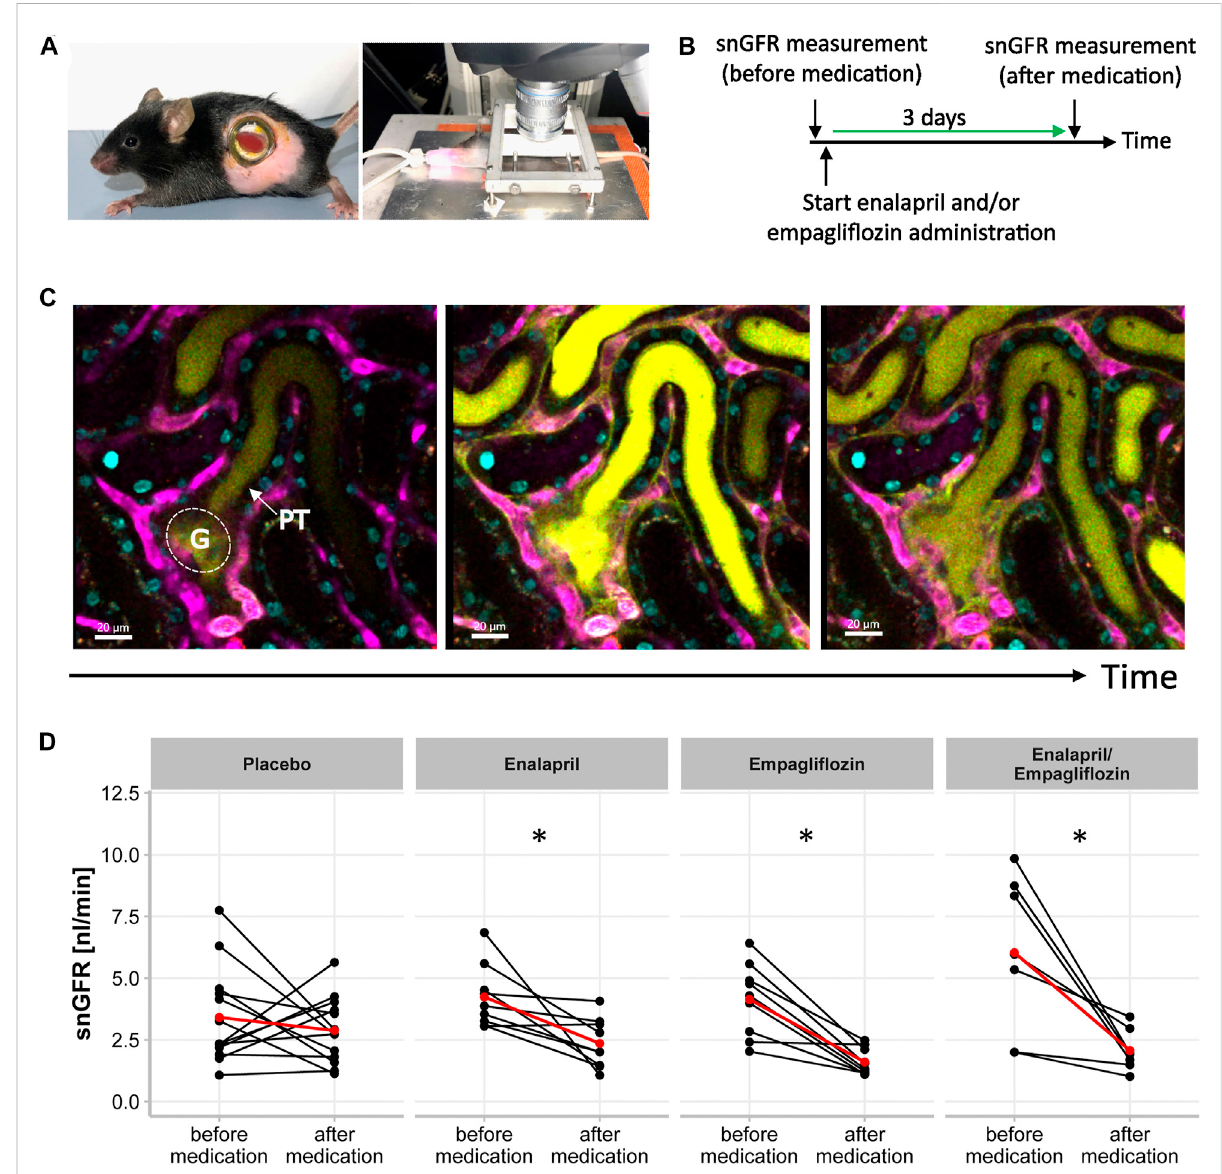
FIGURE 2 Single Nephron Glomerular Filtration Rate in STZ-diabetic mice. (A) Experimental setup for intravital microscopy. Mouse with an abdominal body window for repetitive imaging (right) and anesthetized mouse (endotracheal intubation) with extoriorized and stabilizied kidney for use in upright-imaging systems (left). (B) Timeline of snGFR measurement in the same nephrons of STZ-diabetic mice. After fi rst snGFR measurement (before medication) administration of placebo, enalapril, empagli fl ozin, and enalapril/empagli fl ozin started. Three days later (after medication) the snGFR of the same nephron is measured again. (C) Beginning of fi ltration of the freely fi ltered Lucifer Yellow of one single glomerulus (G) with its subsequent proximal tubule (PT). The middle picture displays the completely fi lled proximal tubule and in the left picture, the fi ltration process is completed. The blood vessels are fl uorescently labeled in magenta and the nuclei in cyan. (D) Alterations of snGFR in the samenephronsbeforeandafter3 daysofplacebo,enalapril,empagli fl ozinandenalapril/empagli fl ozinadministrationinSTZ-diabeticmice.Each point connected by a line represents the effect on GFR of one single nephron by the mentioned medication. The red point connected by a line indicates the mean value each before and after medication. A paired t -test was performed for statistical differences before and after medication in the same nephron. * p < 0.05 before vs. after